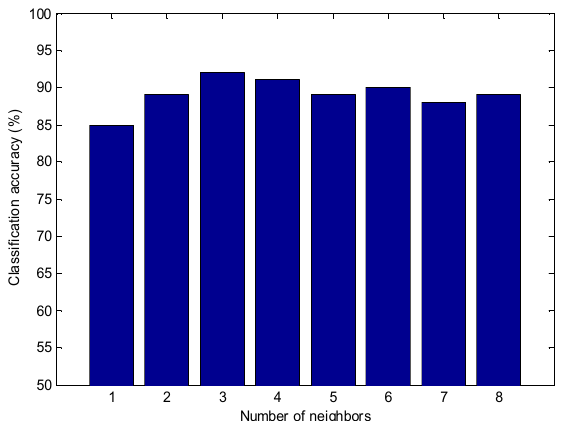
Figure 3. Cross-validation classification accuracy of the K -nearest neighbor (KNN) model according to varying parameter K .